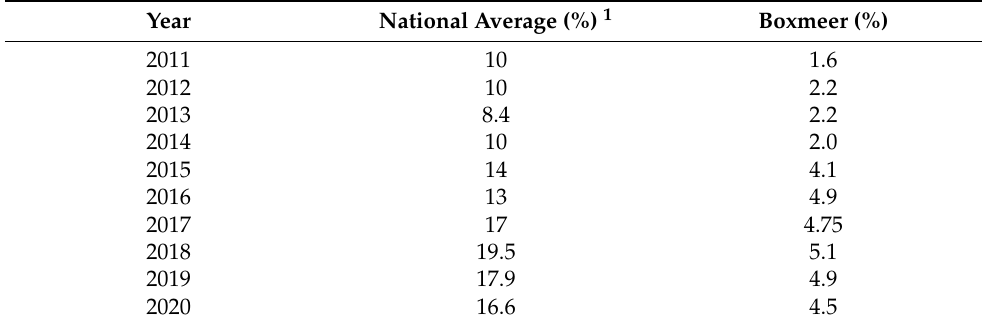
Table 2. Hired external staff relative to total wage bill (source: https://www.aeno.nl accessed on 21 June